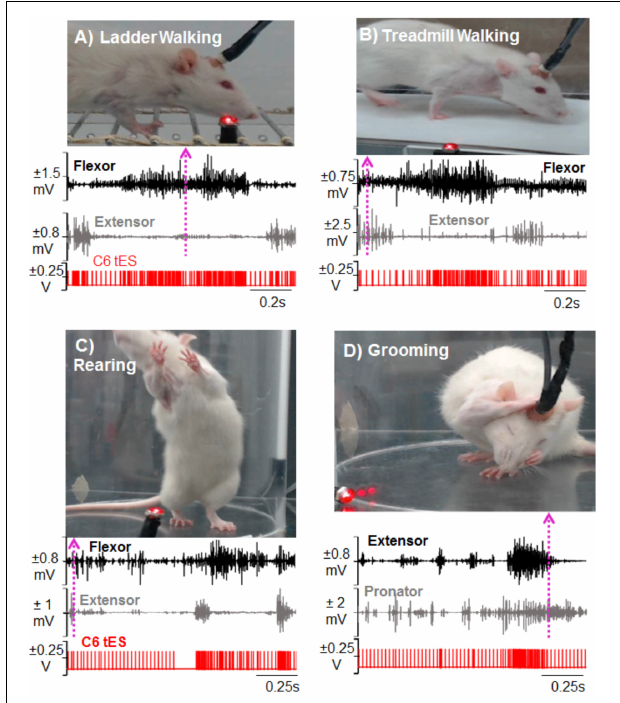
FIGURE 7 | Demonstration of activity-dependent ES of the cervical cord segments triggered by pre-defined EMG signal thresholds (tES) in a mobile experimental setup designed for a multitude of motor tasks. Standstill image that corresponds to a frame in the video is synced with precise timing of an ongoing forelimb EMG activity (dotted arrow matches the frame with the time in the EMG trace). The portable closed-loop setup permitted obtaining data for ladder walking (A) , treadmill walking (B) , rearing (C) , and grooming (D) motor behaviors. Note that during each task, tES occurred following every spike in the EMG burst based upon a user-defined threshold for muscle